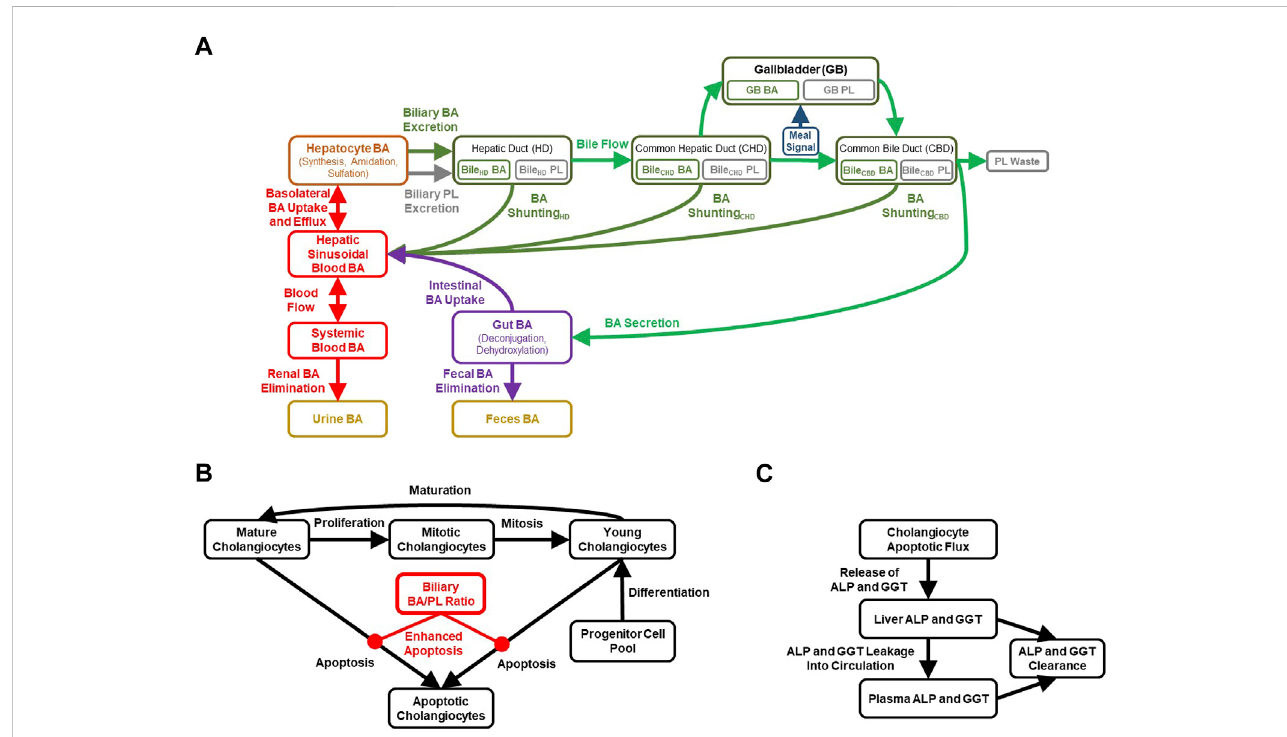
FIGURE 1 Diagrammaticrepresentationofthecholestaticliverinjurymodel,includingfeaturesrelatedto (A) BAandPLhomeostasis, (B) cholangiocytelifecyclefor each of the three bile duct segments, (C) cholestatic liver injury biomarkers. ALP, alkaline phosphatase; BA, bile acid; GGT, gamma-glutamyl-transferase; PL,